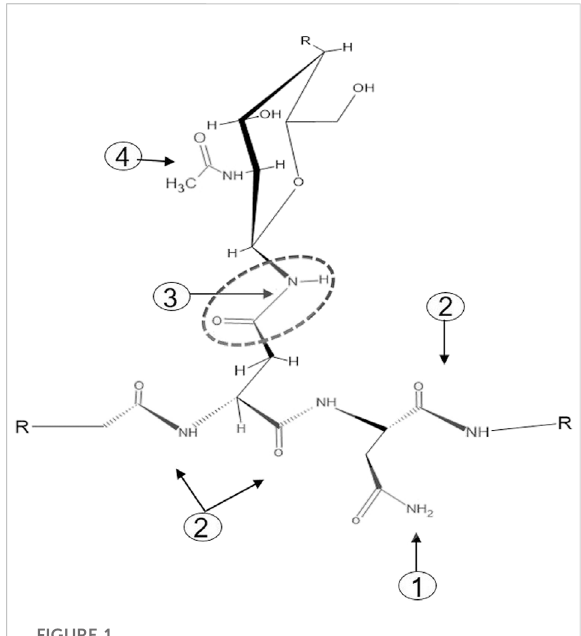
FIGURE 1 The four types of carboxamide structures in